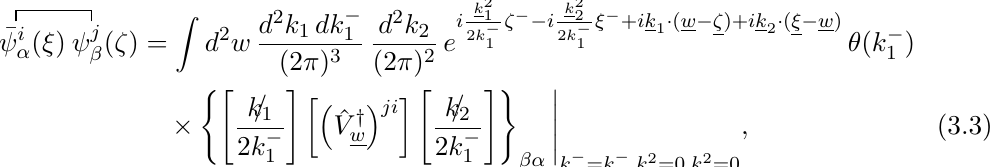
Figure 6. Diagrams of classes B and C with kinematics specified. In the diagram B the antiquark propagates from ζ with momentum k , undergoes a transverse spin-dependent interaction with the 1 proton target at the transverse position w , then propagates to ξ with momentum k C the anti-quark interacts with the shock wave again to the right of the cut, before arriving at the point ξ with momentum k 2